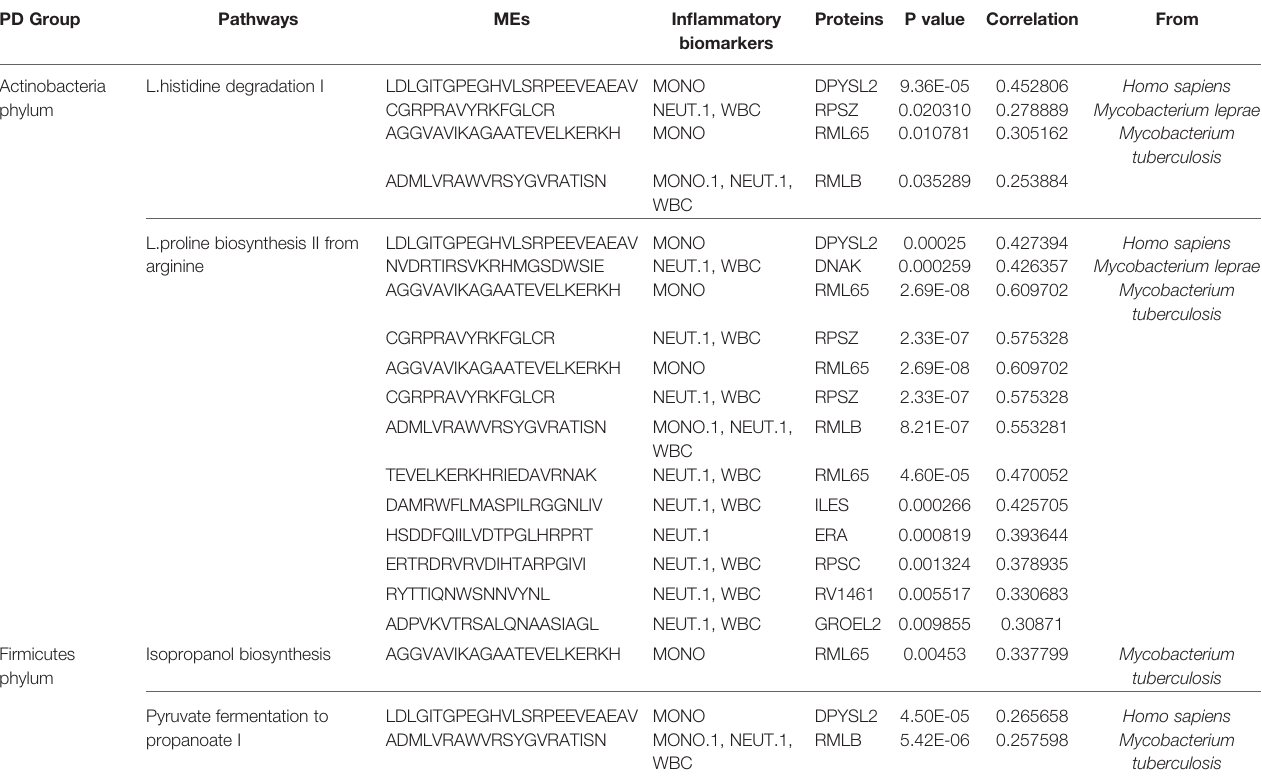
TABLE 2 | Actinobacteria/Firmicutes phylum and in fl ammatory markers associated epitopes in PD were signi fi cantly correlated with pathways enriched in PD. PD